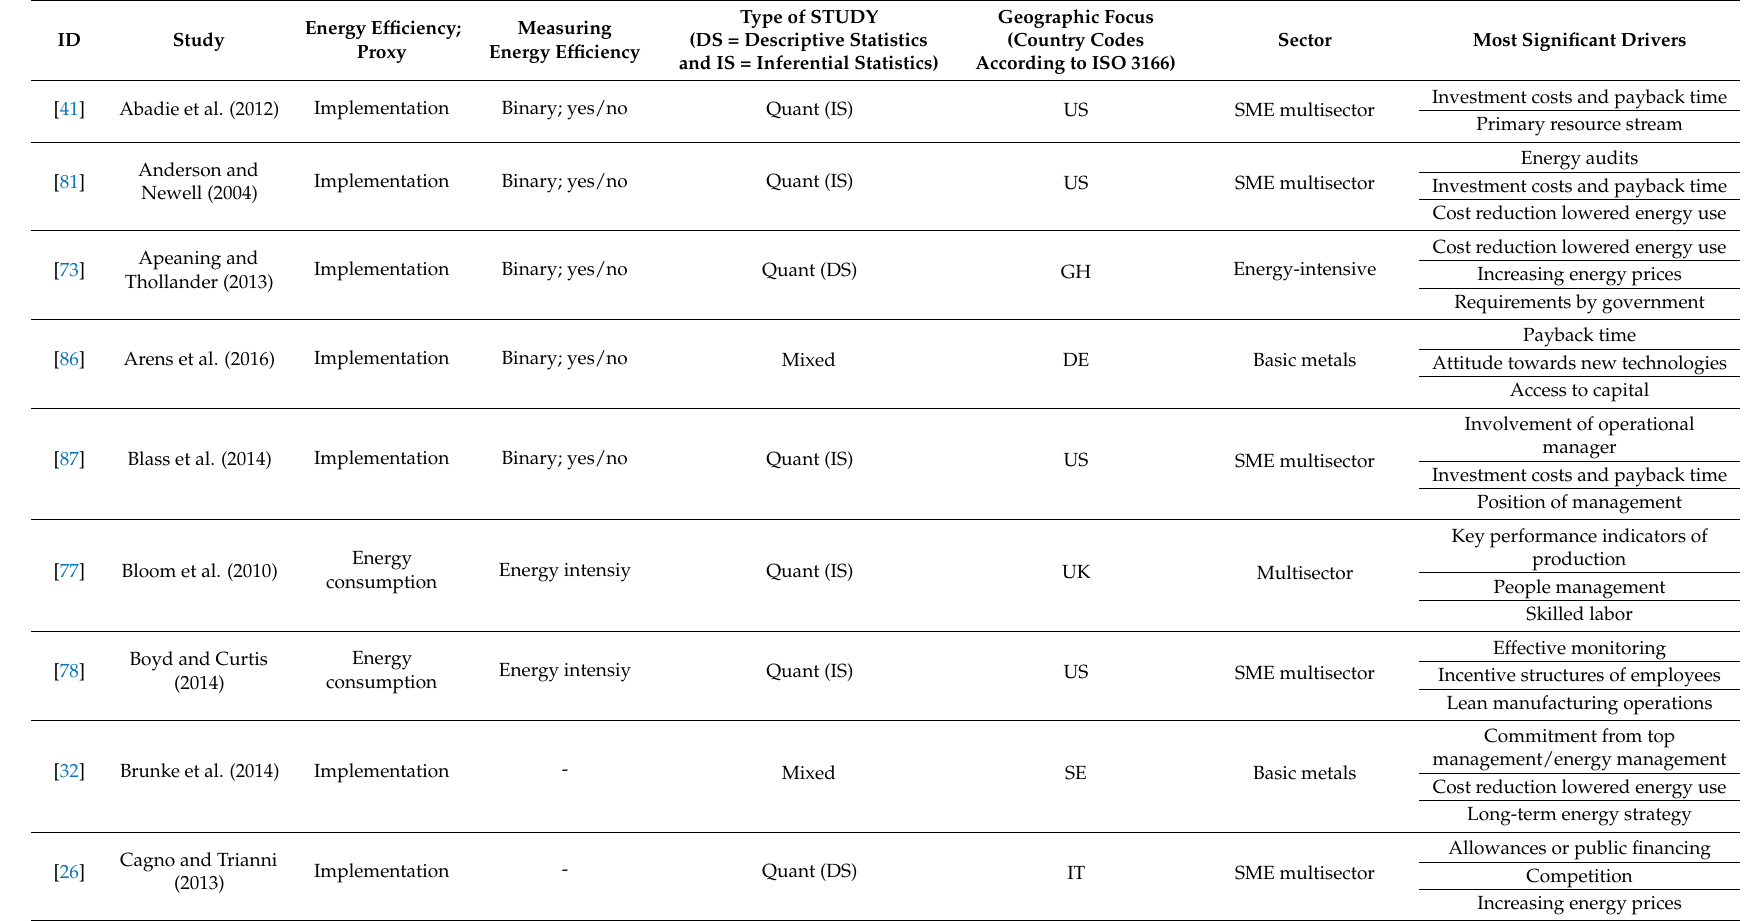
Table A3. Articles included in the systematic literature review